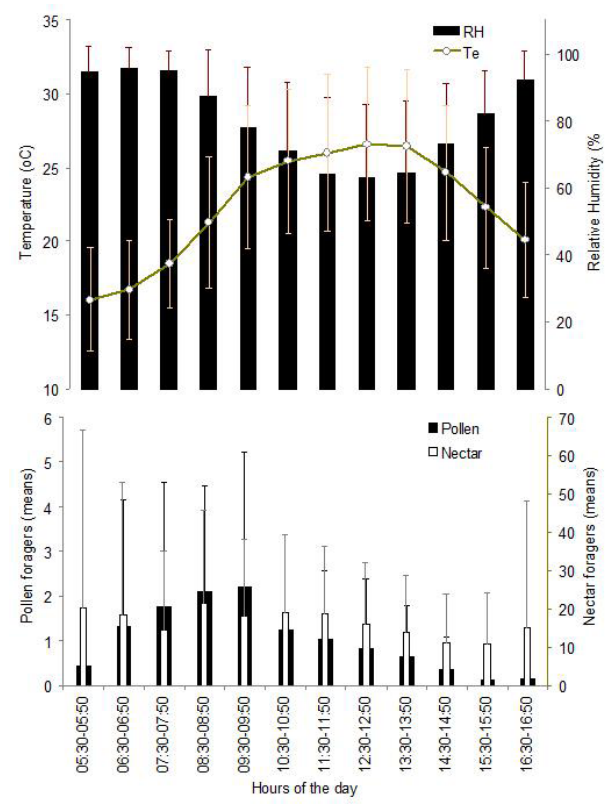
Fig 1 . Pollen and nectar collection by Melipona quadrifasciata anthidiodes related to the environmental temperature intervals. Solid and dashed bars represent standard deviation of pollen and nectar collection, respectively.